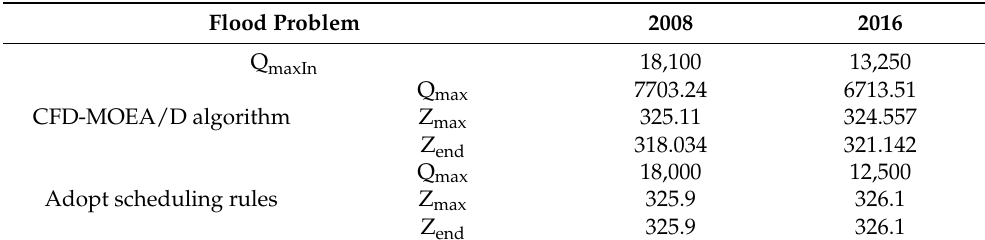
Table 1. Comparison table of scheduling schemes generated by the CFD-MOEA/D algorithm and scheduling